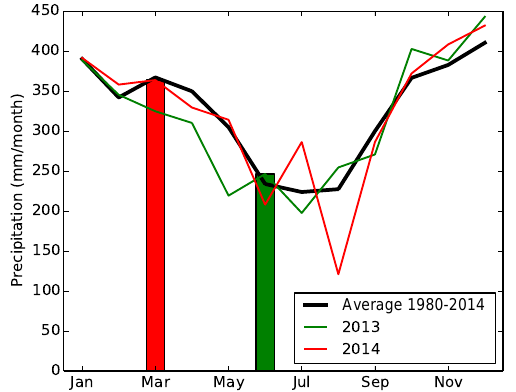
Figure 2. Average monthly precipitation during 1980–2014 (black), and monthly precipitation in 2013 (green) and 2014 (red). The bars indicate the rainfall during our sampling months. It can be seen that the rainfall pattern was not much different from the historical aver- age during these